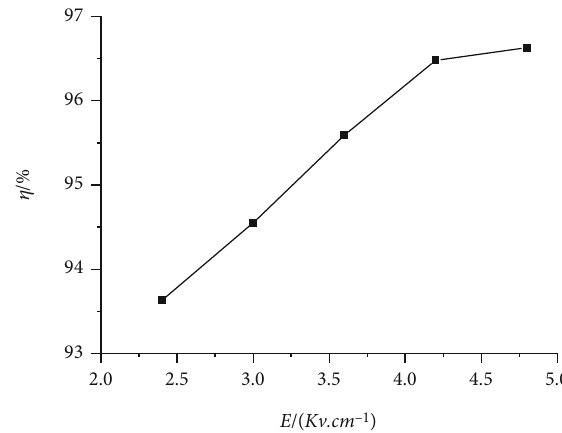
Figure 13: In fl uence curve of mean fi eld strength on dust removal e ffi